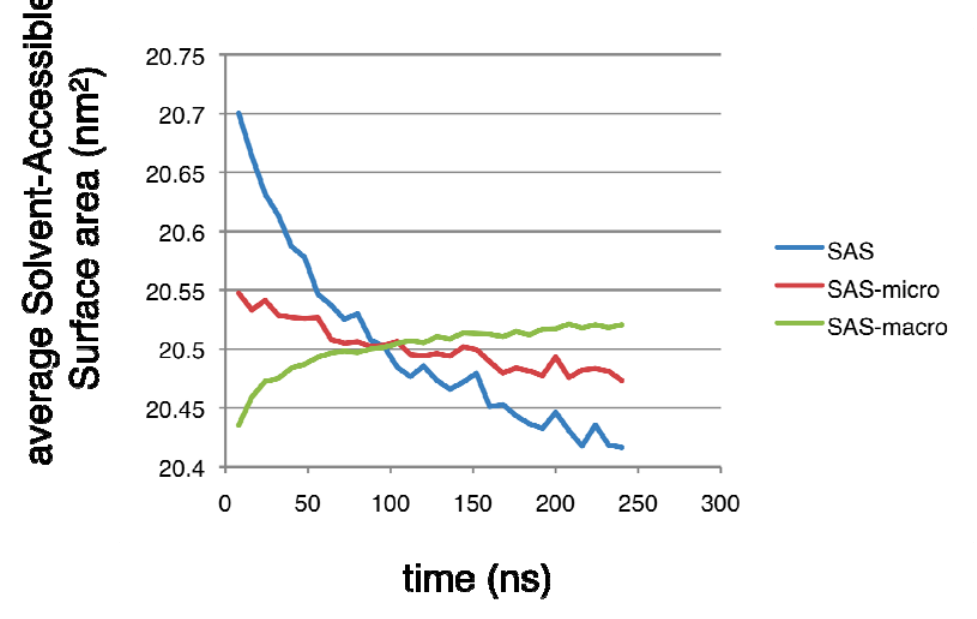
Figure 11. Average C=O solvent-accessible surface area (SAS) over time computed from simulation snapshot data (blue), compared to the average SAS of each microstate projected onto the 4000 microstate populations over time (red), and average SAS of each macrostate projected onto 5 macrostate populations over time (green). The differential effects produced by averaging over microstates and macrostates indicate a sensitive dependence of the SAS observable on short-lived expanded